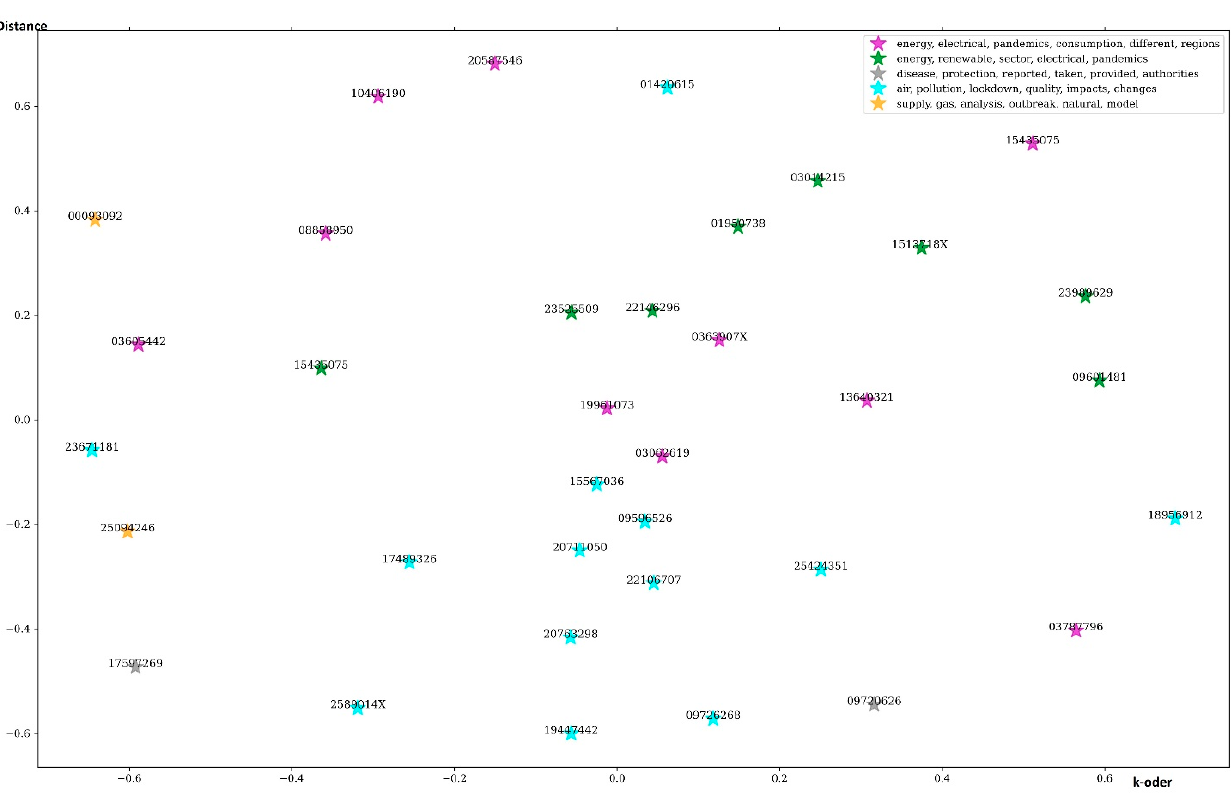
Figure 2. Thematic clusters of journals (by ISSN) within energy using DBSCAN algorithm, 2019–2021. A list with explanations about the numbers found inside the figures is available in Appendix A (Table A1). Source: based on the SciVal database (www.scival.com); data source: Scopus